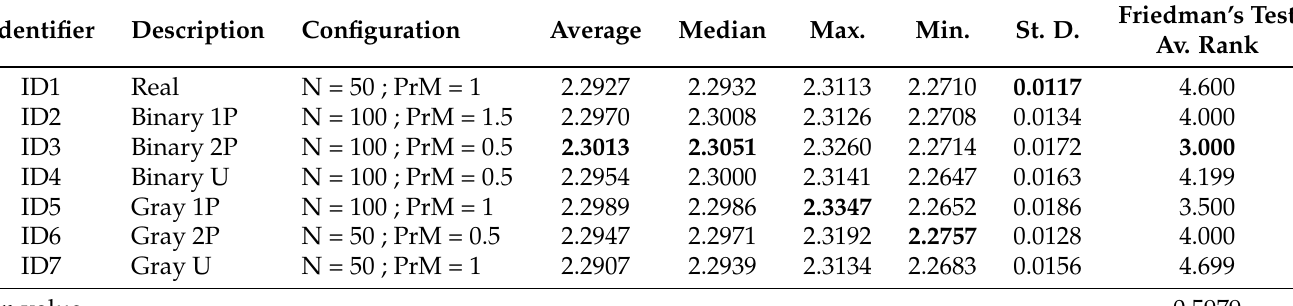
Table 7. Hypervolume statistics (Encoding